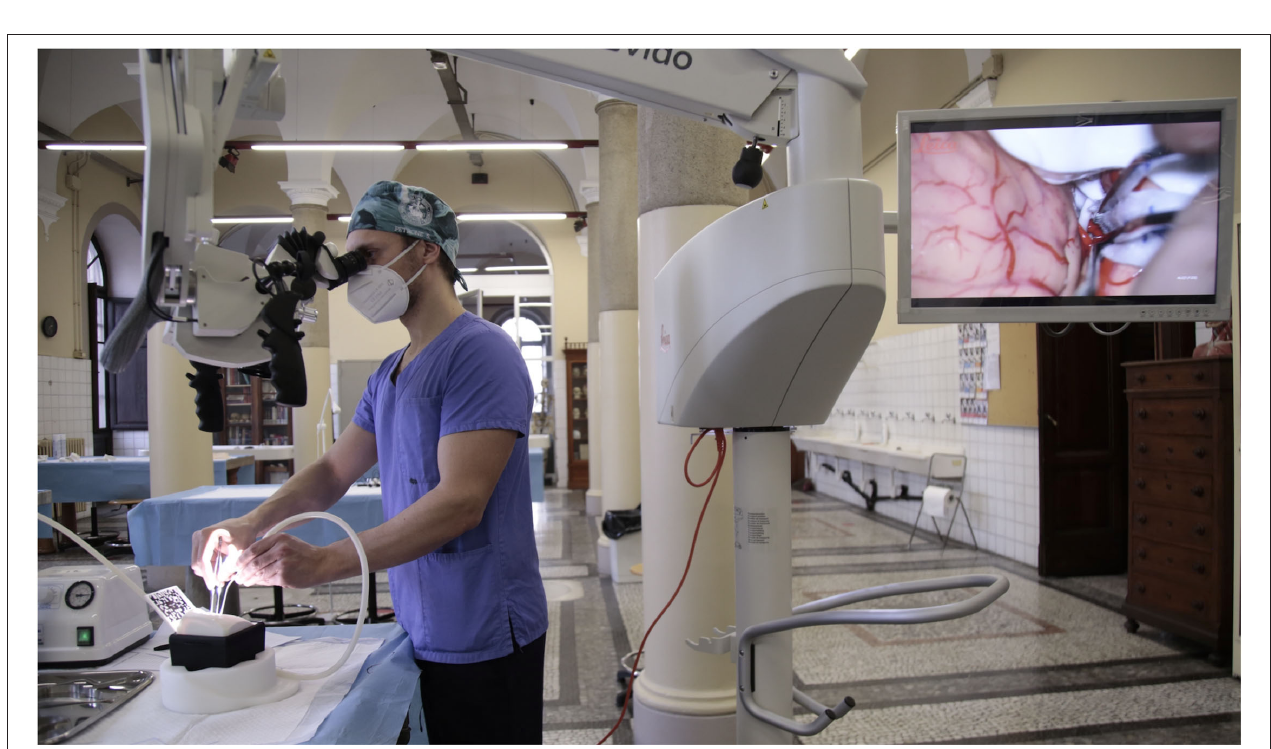
FIGURE 2 | (A-D) The role of AR and the hybrid simulation. (A) AR of a pterional approach. Before performing the craniotomy, it is possible to see the vessels and the brain under the skull by framing the specific QR code through tablet and/or smartphone app; (B) brain parenchyma has been hidden to allow better evaluation of dural venous system and ventricular system; (C) AR used to better evaluate white matter fiber anatomy; (D) application of AR in endoscopic endonasal approach allows to identify anatomical landmarks before entering the nose.